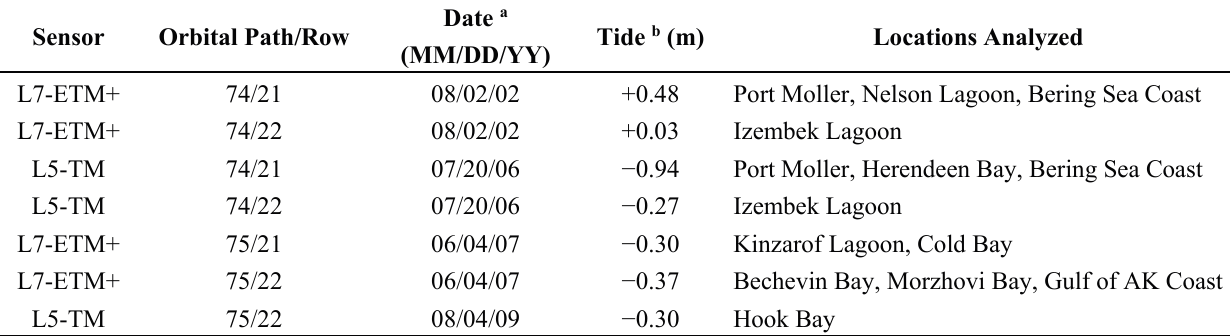
Table 1. Landsat imagery used to map eelgrass distribution on the lower Alaska